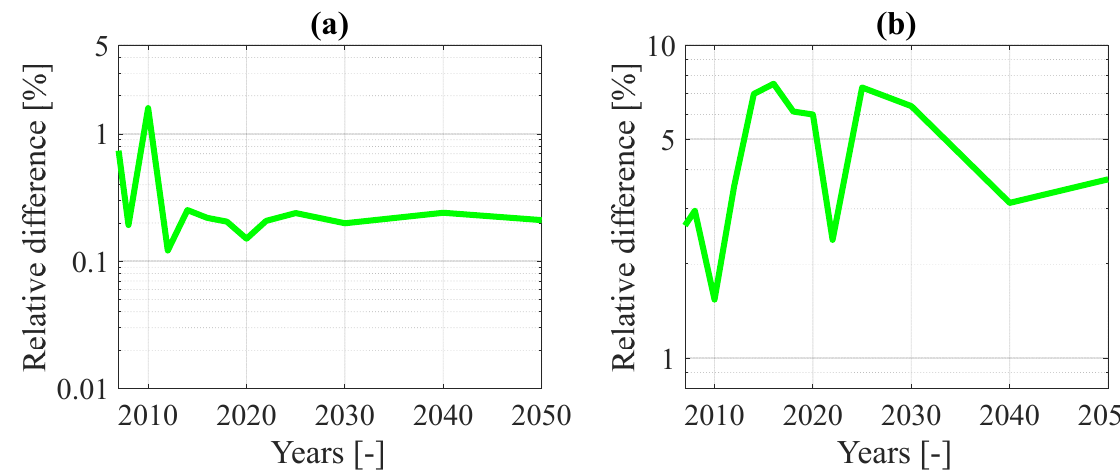
Figure 12. ( a ) Maximum relative difference associated to the total production of residential, commercial and agriculture final service demands. ( b ) Average relative difference associated to the optimal technology mix for residential space heating.